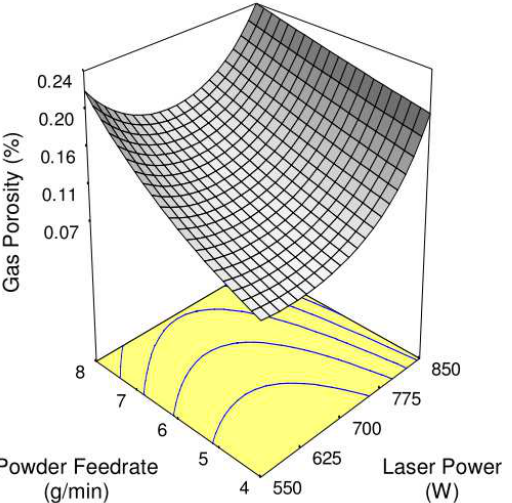
Figure 17. The influence of the laser power and powder feeding rate on porosity in the LMD process [23].